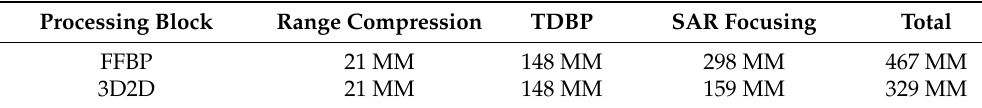
Table 5. Rough number of operations required to form an SAR image using the two described algorithms.